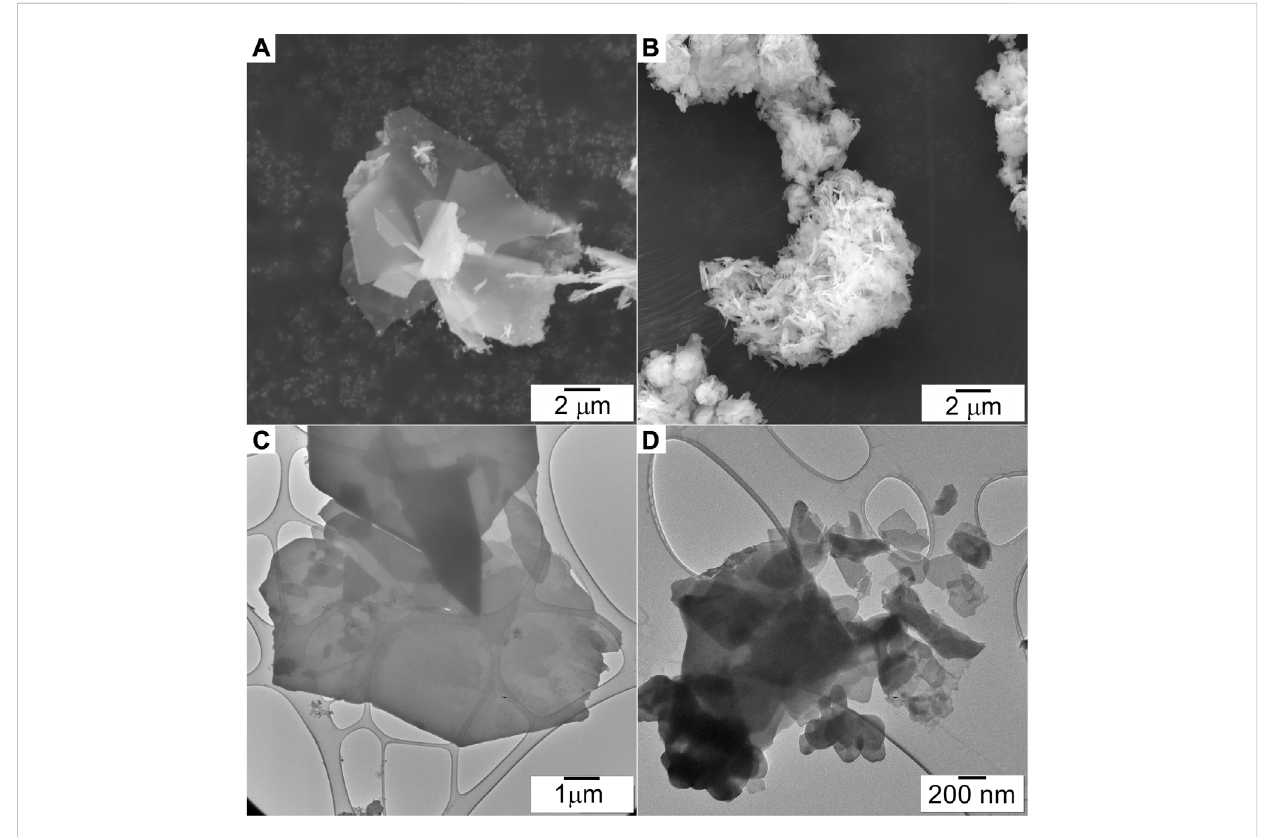
FIGURE 2 SEM images of the ZHN COPP (A) and ZHN SSR (B) samples. TEM images of the ZHN COPP (C) and ZHN SSR (D)